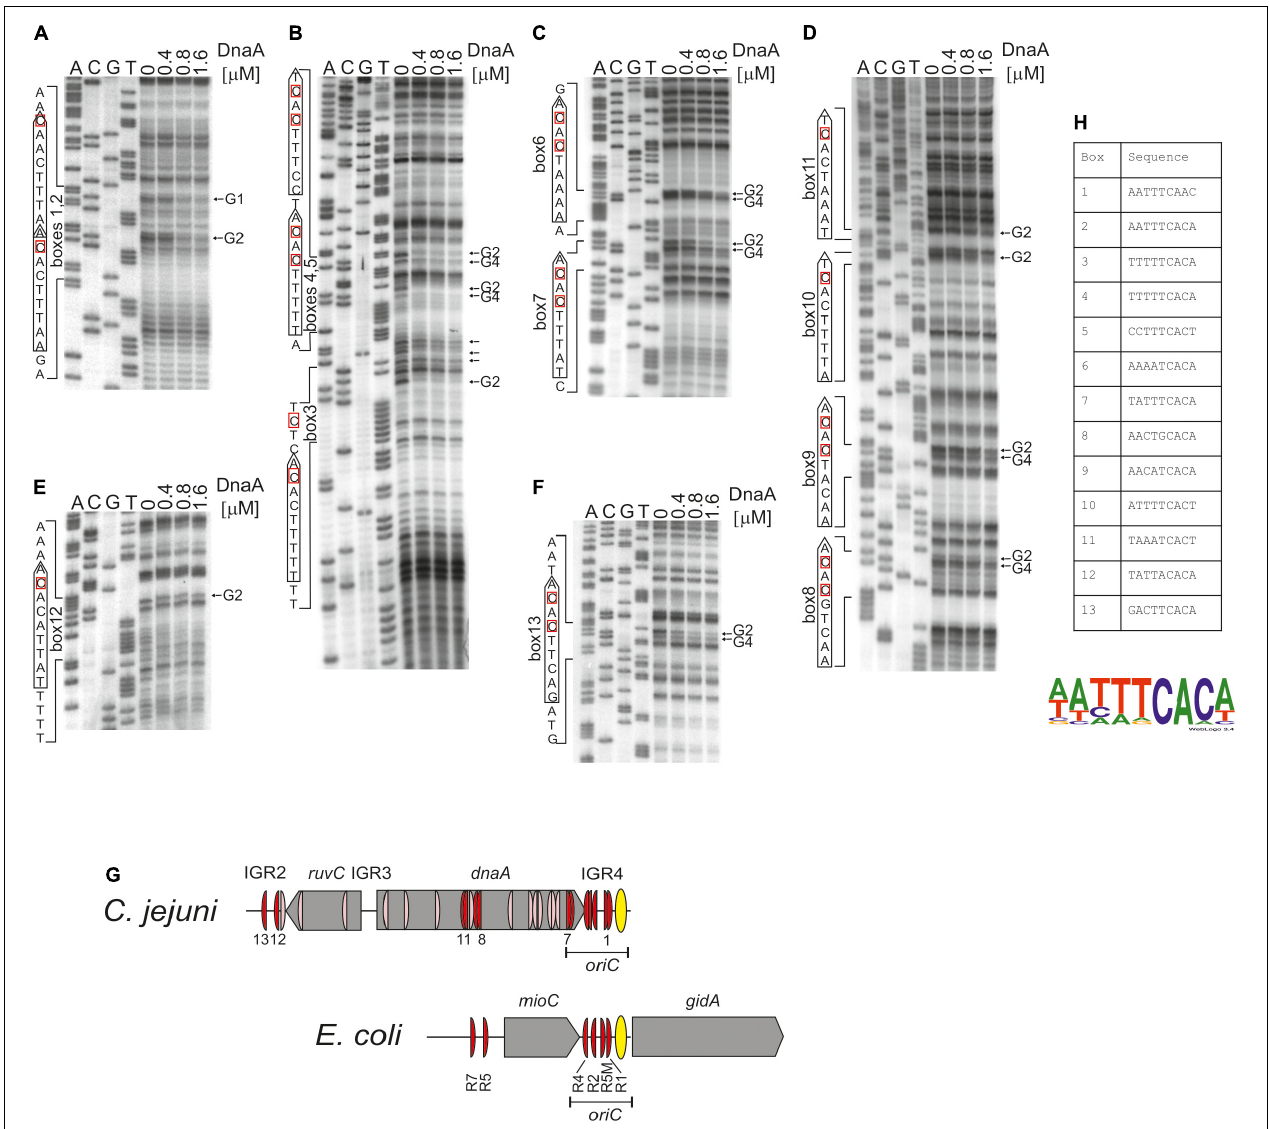
FIGURE 4 | Identification of DnaA boxes in the C. jejuni IGR2, IGR4 regions and the dnaA gene by in vitro DMS footprinting. (A–F) pOC_24 was incubated with the indicated concentrations of the 6HisDnaA protein, methylated with DMS and used as a template for PE reactions; primers used to map DnaA boxes are specified in Supplementary Table S2. Protected guanosine residues (G) are indicated by arrows, and the complementary cytosine residues in the DnaA box are indicated by red boxes. Densitometric plots are presented in Supplementary Figure S6. (G) Schematic presentation of the localization of DnaA boxes identified in silico (light red) and detected by DMS footprinting (red). The E. coli oriC region is presented for comparison of the most characteristic oriC features; only strong R-type DnaA boxes are marked (Hansen et al., 2007; Leonard and Grimwade, 2015). (H) Sequences of in vitro -identified C. jejuni DnaA boxes. The WebLogo was used to create a consensus sequence of the C. jejuni DnaA box.